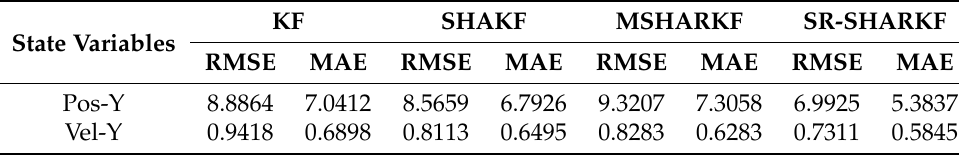
Table 8. Dynamic parameter error evaluation in the Y-axis